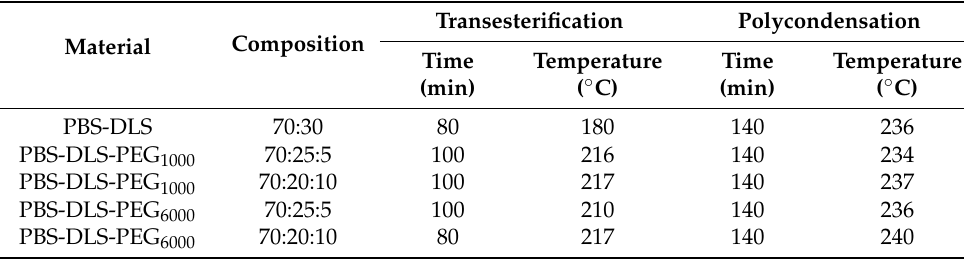
Table 1. A summary of the synthesis conditions and copolymer